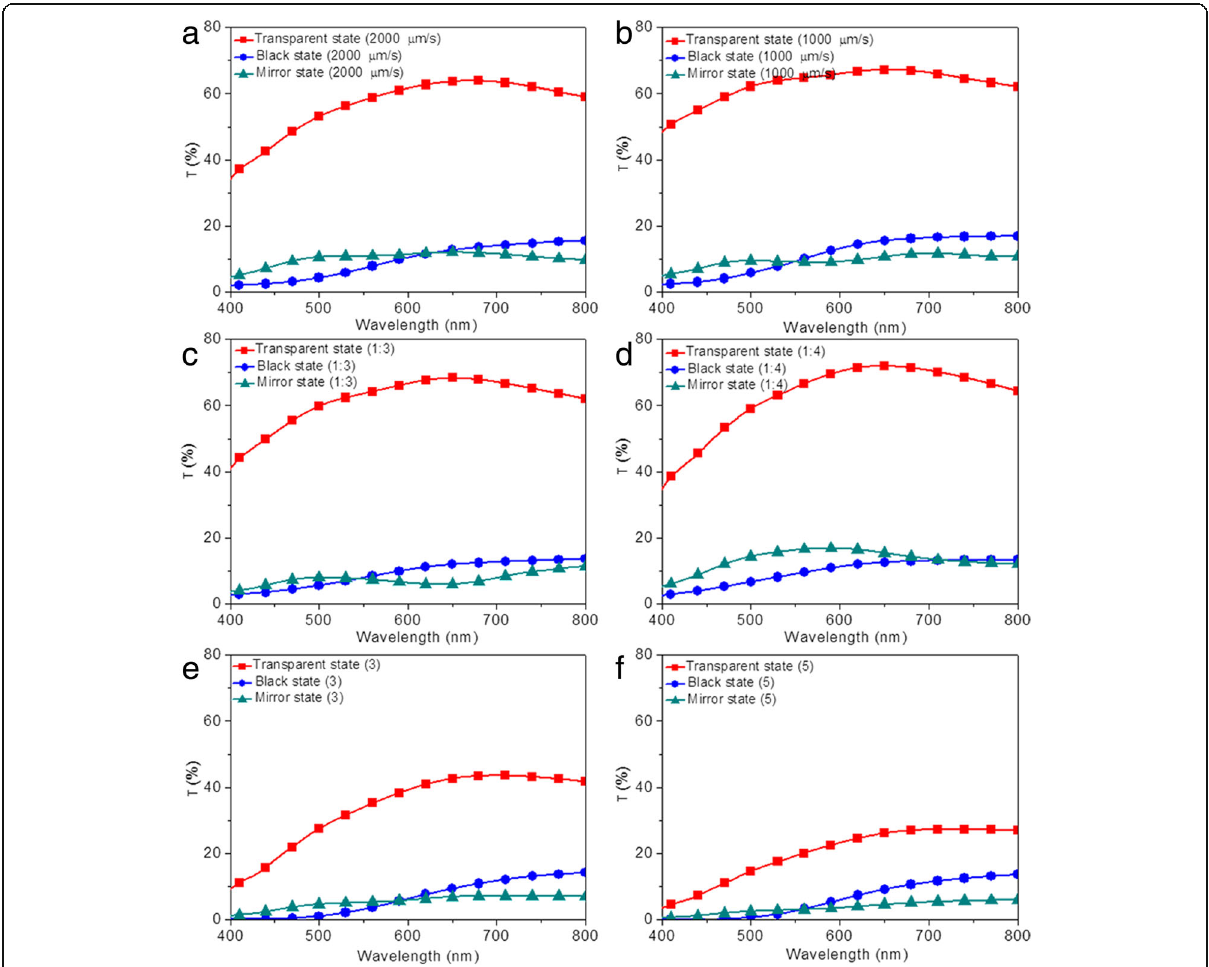
Fig. 8 (Color online) Optical properties of the electrodeposition-based electrochromic device in transparent ( red ), black ( blue ), and mirror states ( green ). Transmittance spectra of modified devices prepared with different fabrication conditions, including a lifting speed of 2000 μ m/s, b lifting speed of 1000 μ m/s, c precursor concentration of 1:3, d precursor concentration of 1:4, e dipping number of 3, and f dipping number of